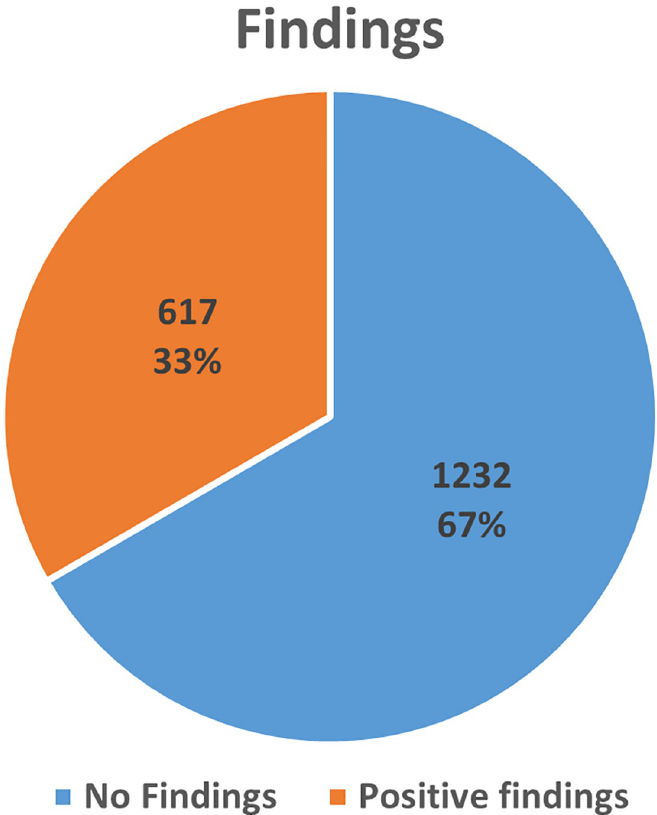
Fig 2. Prevalence of the paranasal sinuses among the patients. After assessing the CT scans, the data showed that the most frequently affected were maxillary sinuses, with a total (31.7%, n = 586) of all positive cases. unilateral maxillary antrum sinusitis was the most frequent pathologies (20.49%, n = 249) of all positive findings, maxillary polyps (Fig